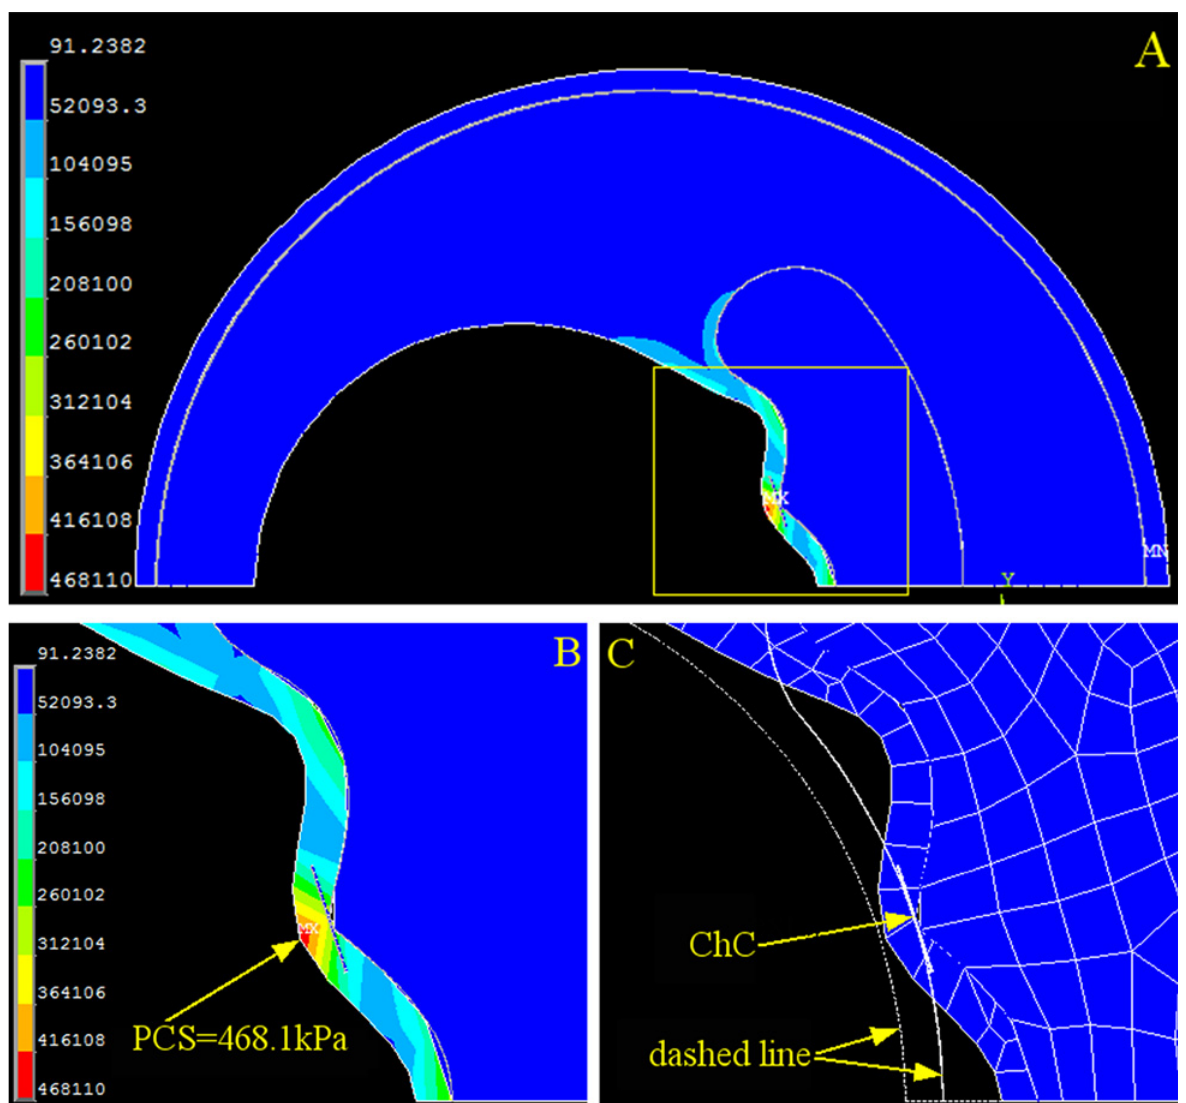
Fig 6. Stress and Strain of the Artery with One Cholesterol Crystal halfway between the Shoulder and the Cap Center. (A) Stress distribution of the overall coronary artery. (B) Contour plot of the stress on the fibrous cap (yellow dashed box in A). (C) Contour plot of the strain on the fibrous cap. The dashed line is the original contour before loading, and the meshed section is the deformed cap after loading. PCS: peak circumferential stress. ChC: cholesterol